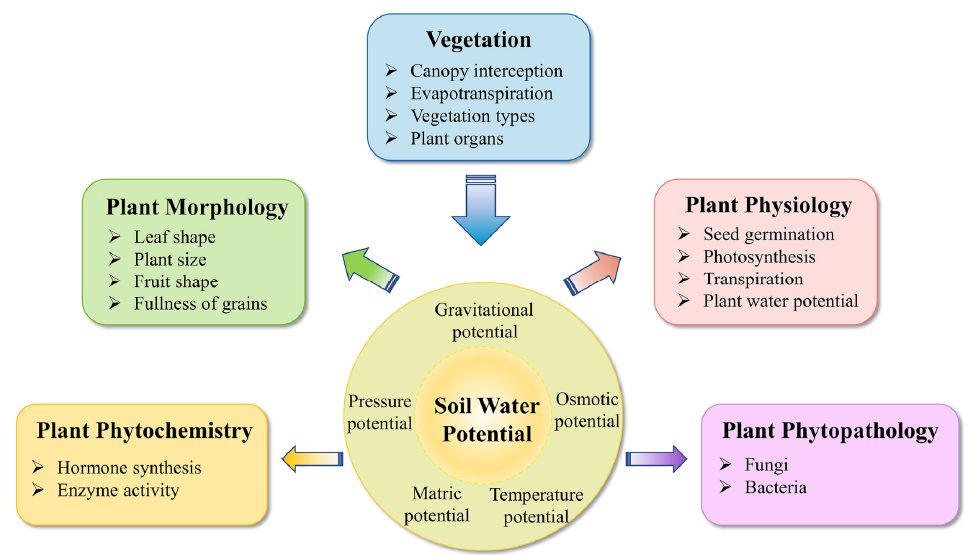
Figure 4. Factors influencing the interaction between SWP and vegetation.